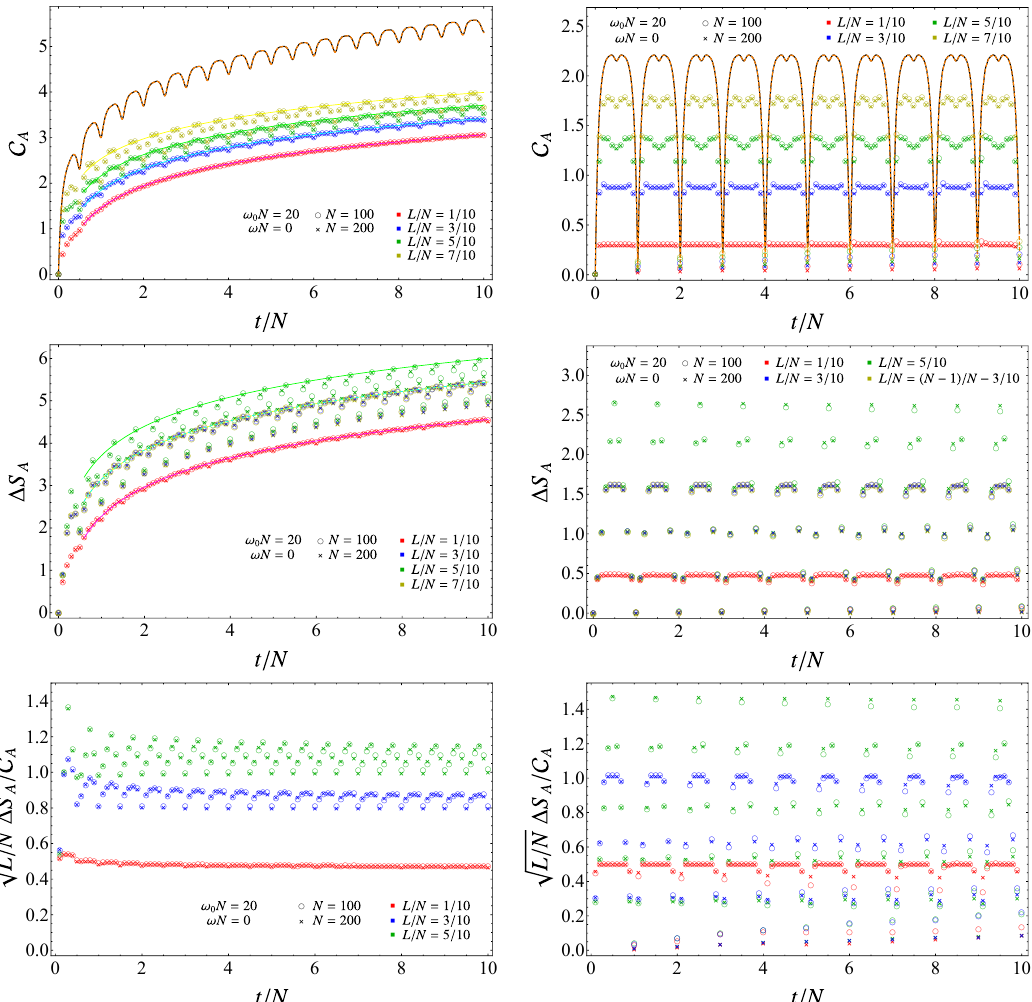
Figure 8 . Temporal evolution of C A in (4.6) (top panels), of ∆ S A in (4.7) (middle panels) and of p L/N ∆ S A / C A (bottom panels) after the global quench with a gapless evolution Hamiltonian and ω 0 N = 20 , for harmonic chains with either PBC (left panels) or DBC (right panels), in the same setups of figure 6 are